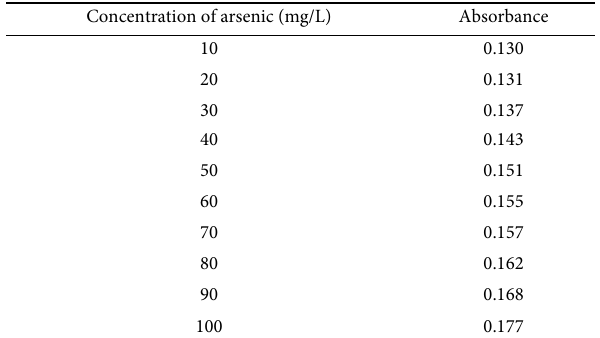
Table 2. Concentration and absorbance reading for standard curve.